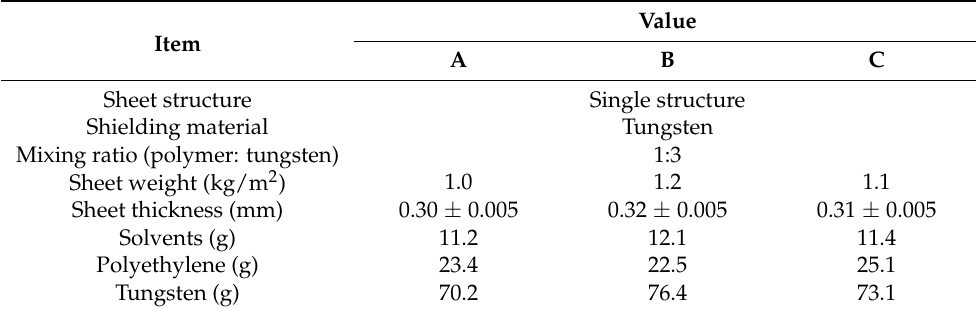
Table 2. Fabrication composition of radiation-shielding